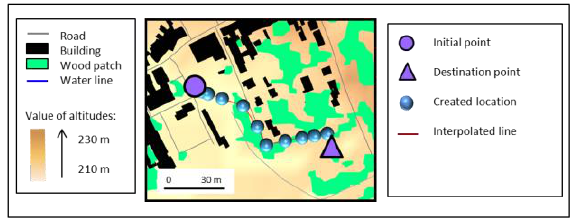
Figure 3. The object-accurate function: the points of the trajectory built step by step by an agent. In this example, buildings are avoided and roads have permeability values.